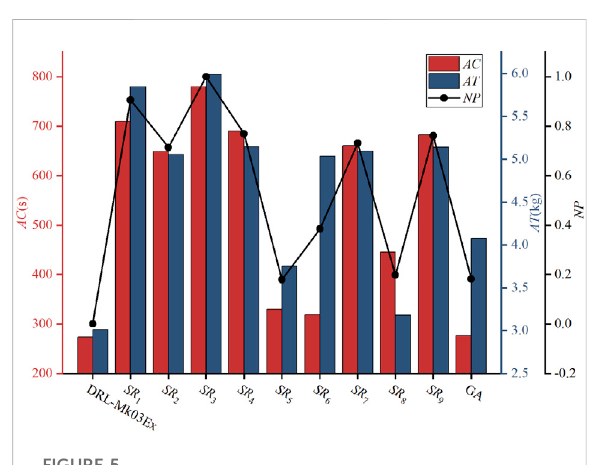
FIGURE 5 Performance of DRL-Mk03Ex over the Mk03Ex